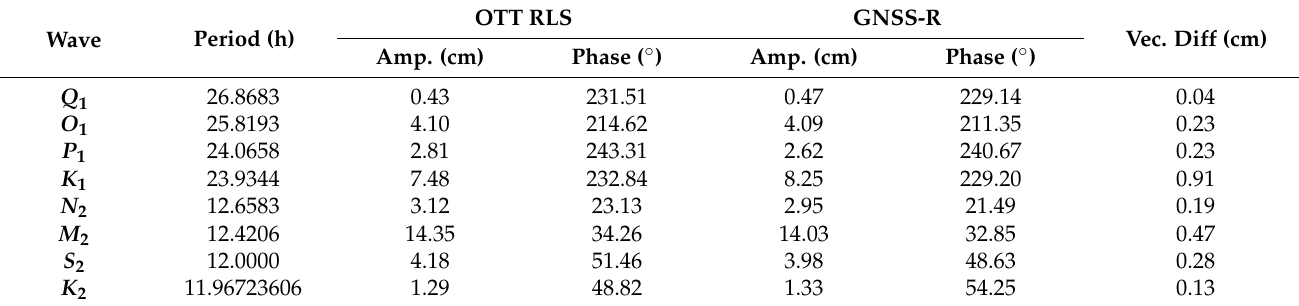
Table 2. Eight major tidal constituents at Port-au-Prince tide gauge station .